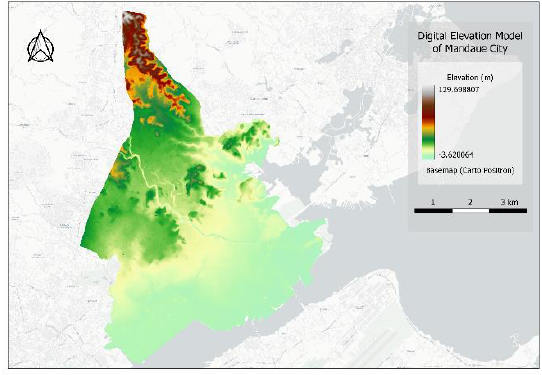
Figure 2 . Digital elevation model of Mandaue